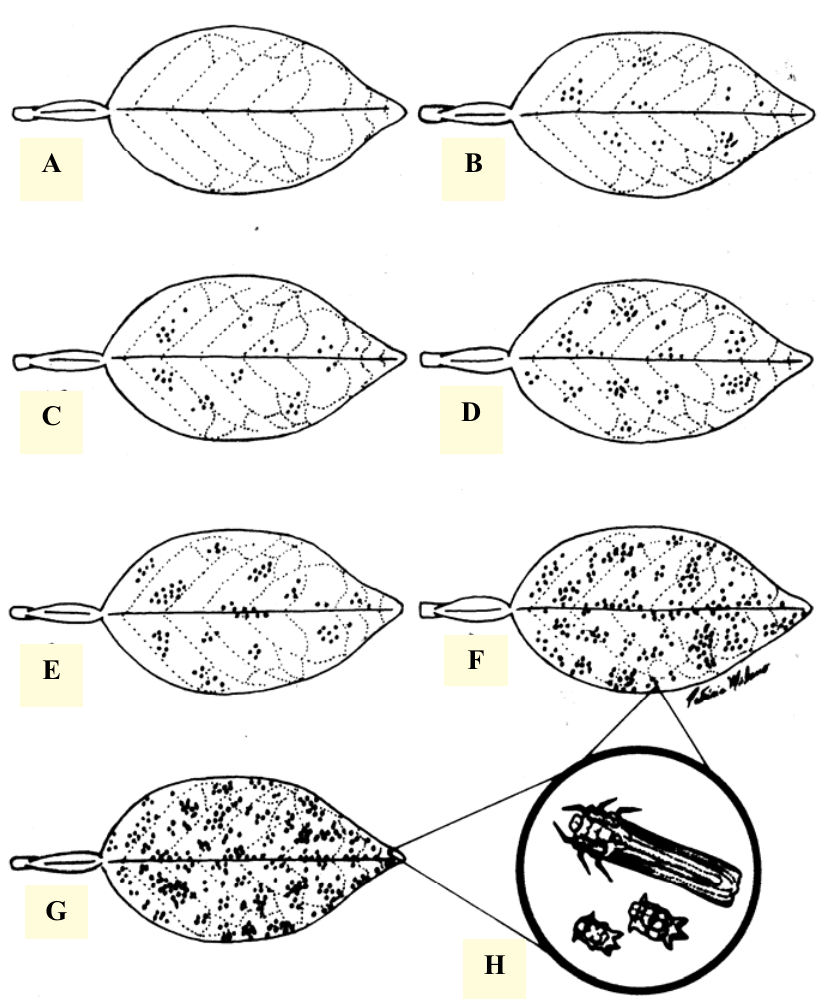
Fig. 1 – Damaged leaf area intervals of O. praelonga on rangpur lime used to measure plant physiological parameters: 0% = 0 scales (A); 6% = ± 35 (B); 7% = ± 40 (C); 13% = ± 70 (D); 14% = ± 80 (E); 40% = ± 220 (F); > 40% = > 220 scales (G); female and nymphs